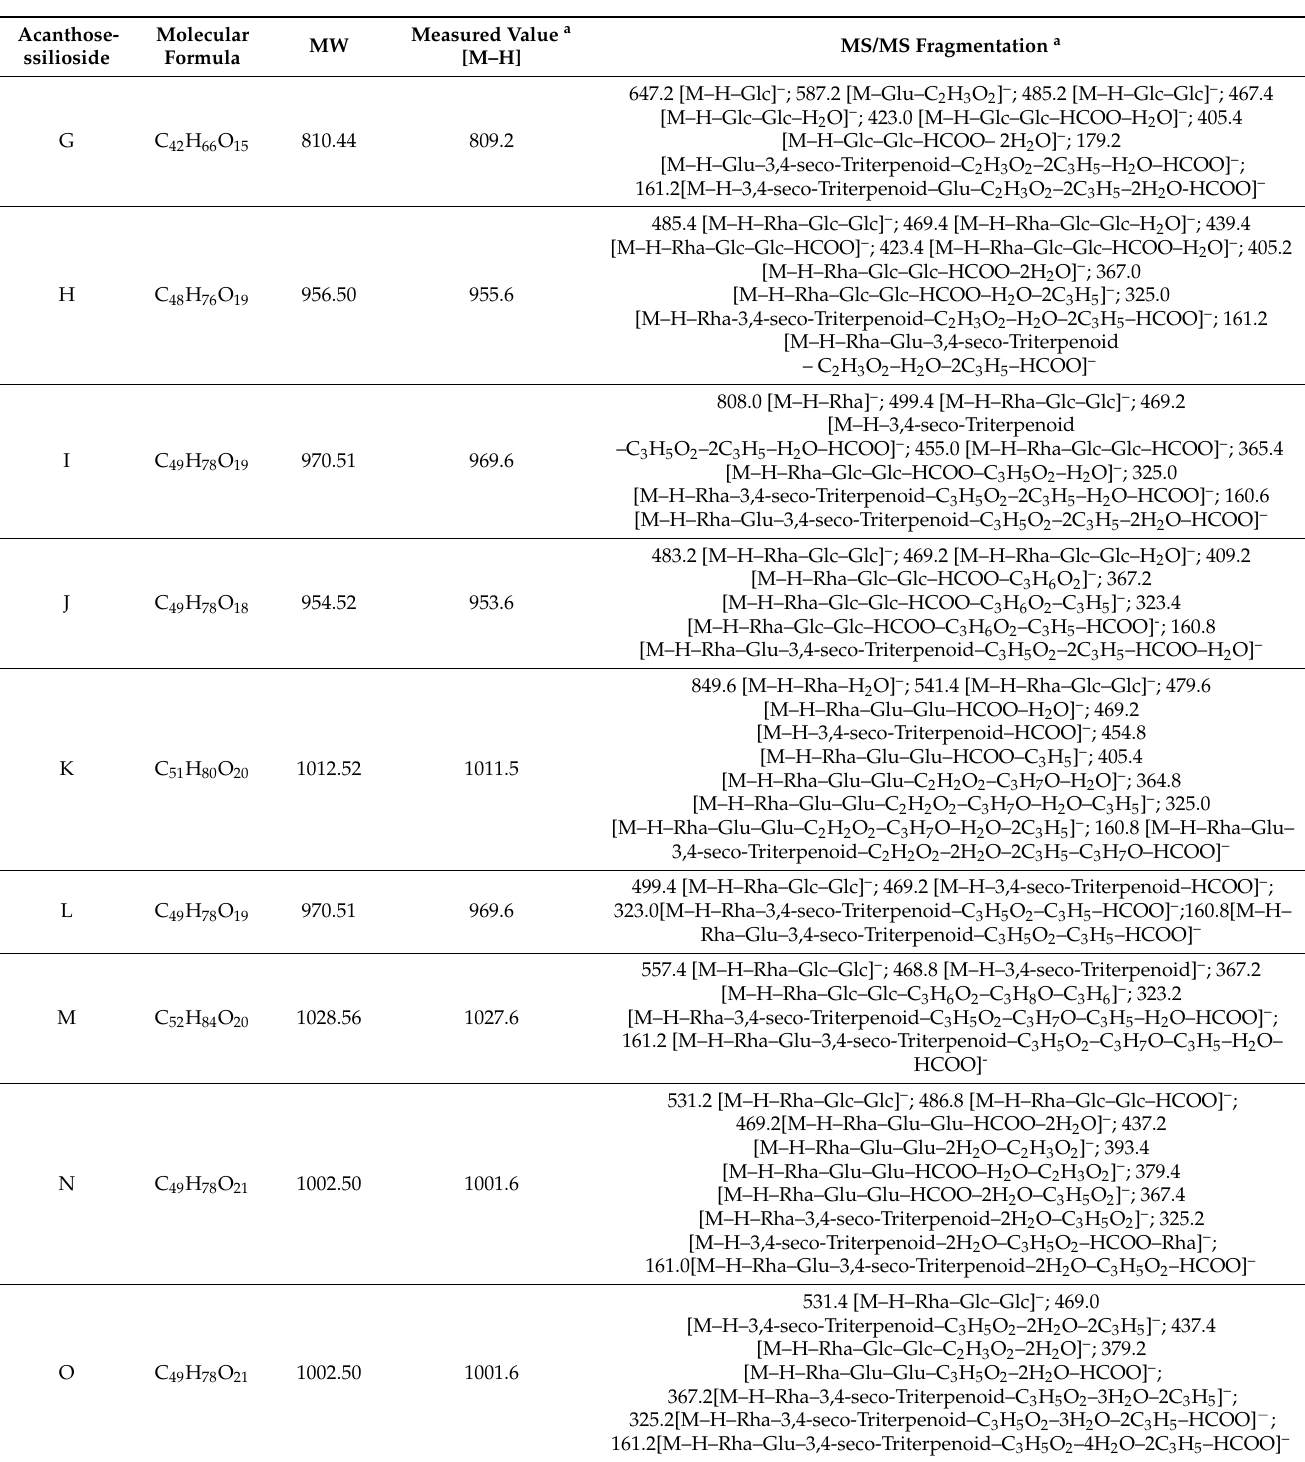
Table 4. UPLC–MS/MS data-negative ion mode for acanthosessilioside G–O identified in